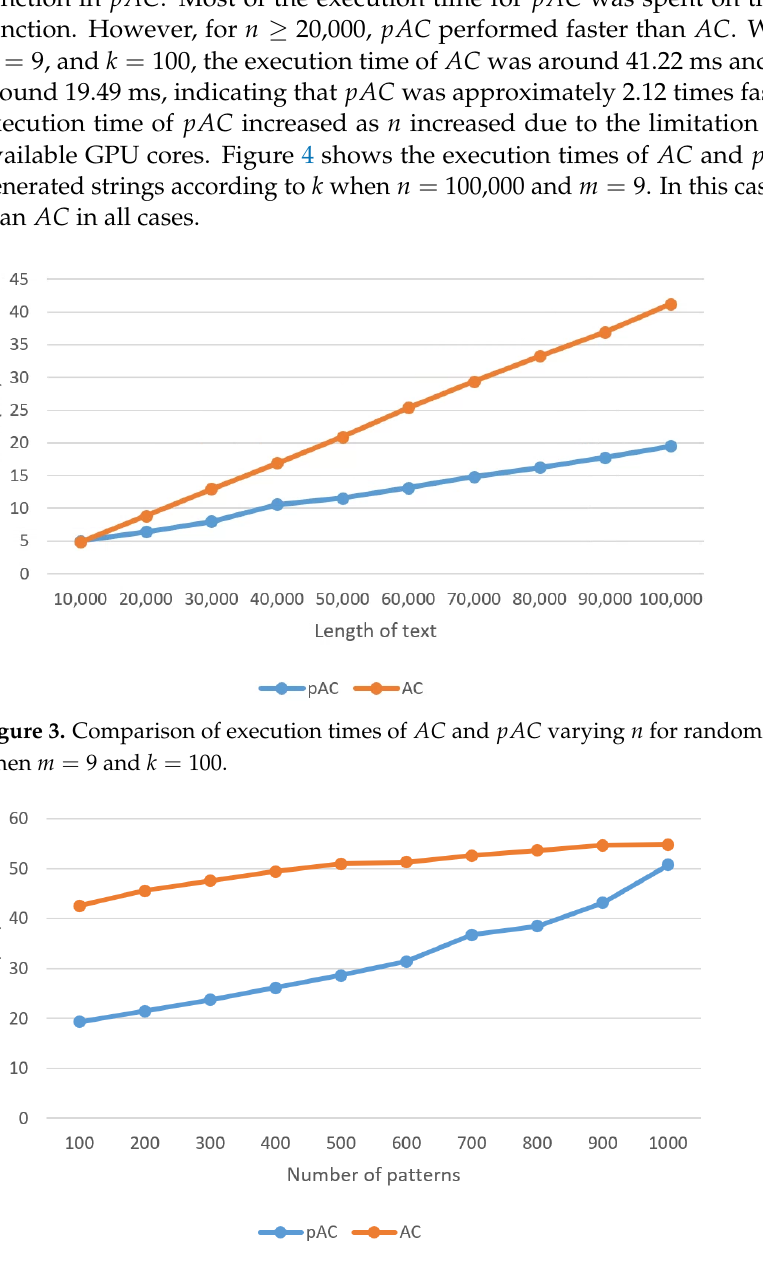
Figure 4. Comparison of execution times of AC and pAC varying k for randomly generated strings when n = 100,000 and m =